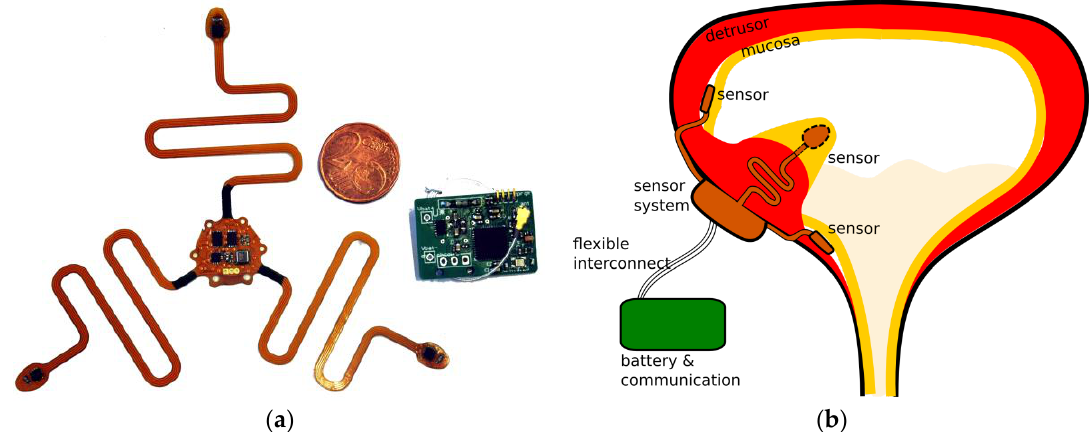
Figure 2. The physical design of the measurement system. ( a ) The fabricated system. Left: the flexible sensor system with three sensing arms. Right: the subcutaneous wireless communicating system. Both subsystems are depicted, yet without final biocompatible packaging; ( b ) The intended way of implantation. Only the three tips of the flexible sensing system are implanted submucosally, while the rest of the sensor system is on the outside of the bladder wall. The battery and communication system is implanted